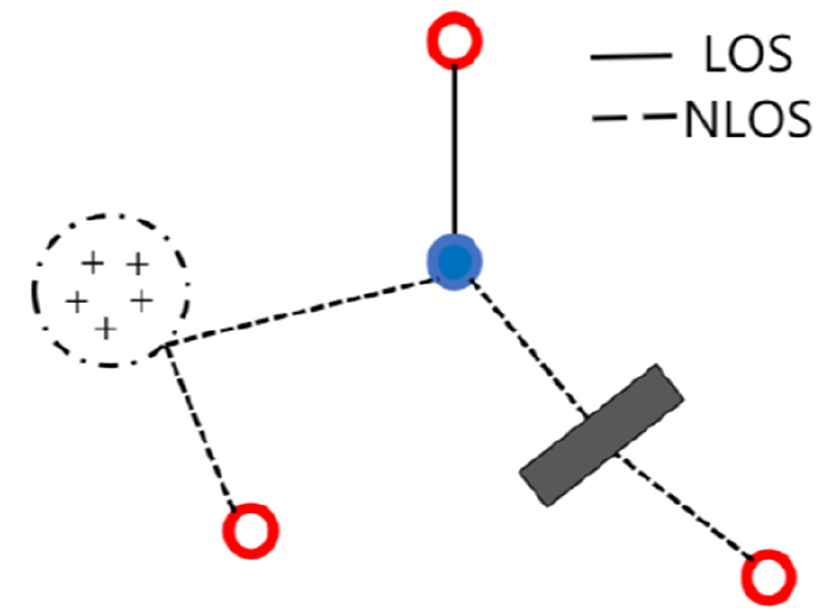
Figure 1. UWB propagation path classi fi